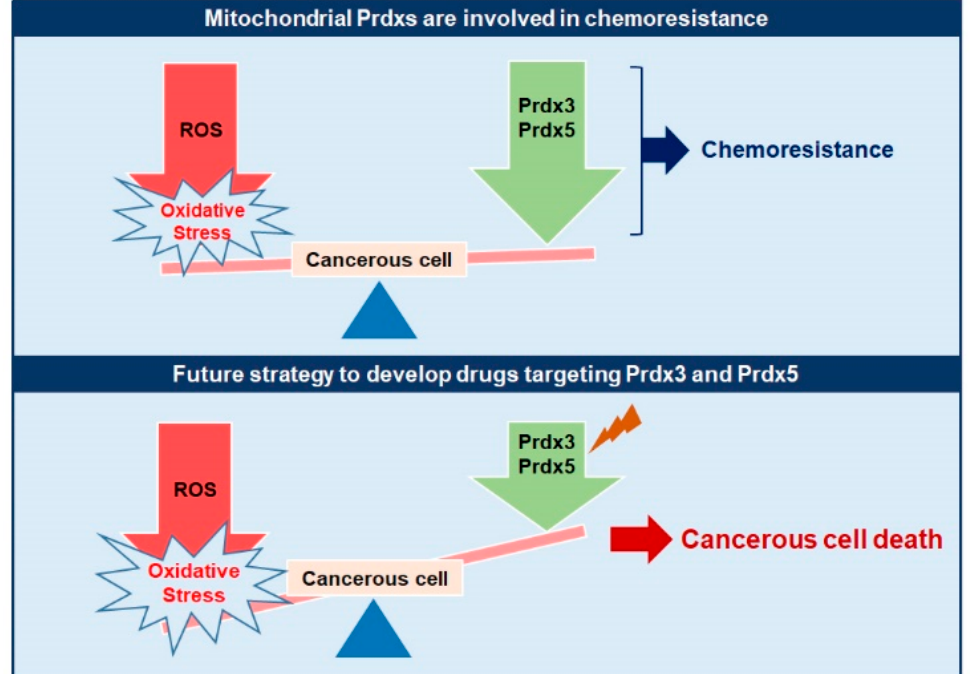
Figure 5. Mitochondrial Prdxs in development of Chemoresistance. The upregulated expression of mitochondrial Prdxs is associated with the development of drug resistance in a number of cancer types leading to complications in cancer treatment. These upregulated Prdxs can be specifically targeted in cancerous cells to develop new drugs against cancer with better efficacy and without causing any harm to the normal cells.